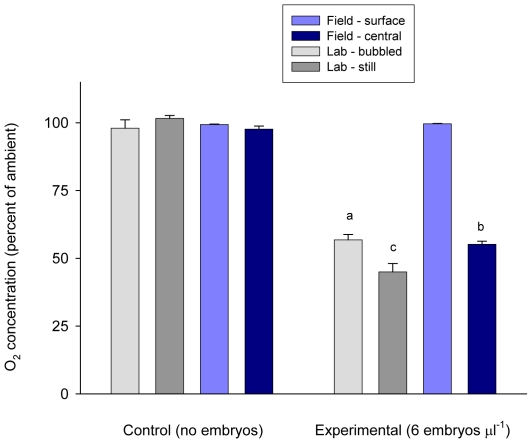
Internal O2 of artificial masses in the lab and field.Internal O2 measured in the lab (grey bars) and field (blue bars) for agarose masses containing no embryos (control; left) or containing embryos of Dendraster excentricus at 6 embryos ml−1 (experimental; right), expressed as % concentration relative to the water column. For lab masses, light grey bars are measurements taken of masses calibrated in air-bubbled water; dark grey bars represent still water conditions. For field masses the light blue bars represent readings taken at the surface of the mass and dark blue bars are readings from the center. Letters (a, b, c) above bars indicate significant differences between means. Each bar represents the mean measurements taken from four (experimental) or five (control) masses.